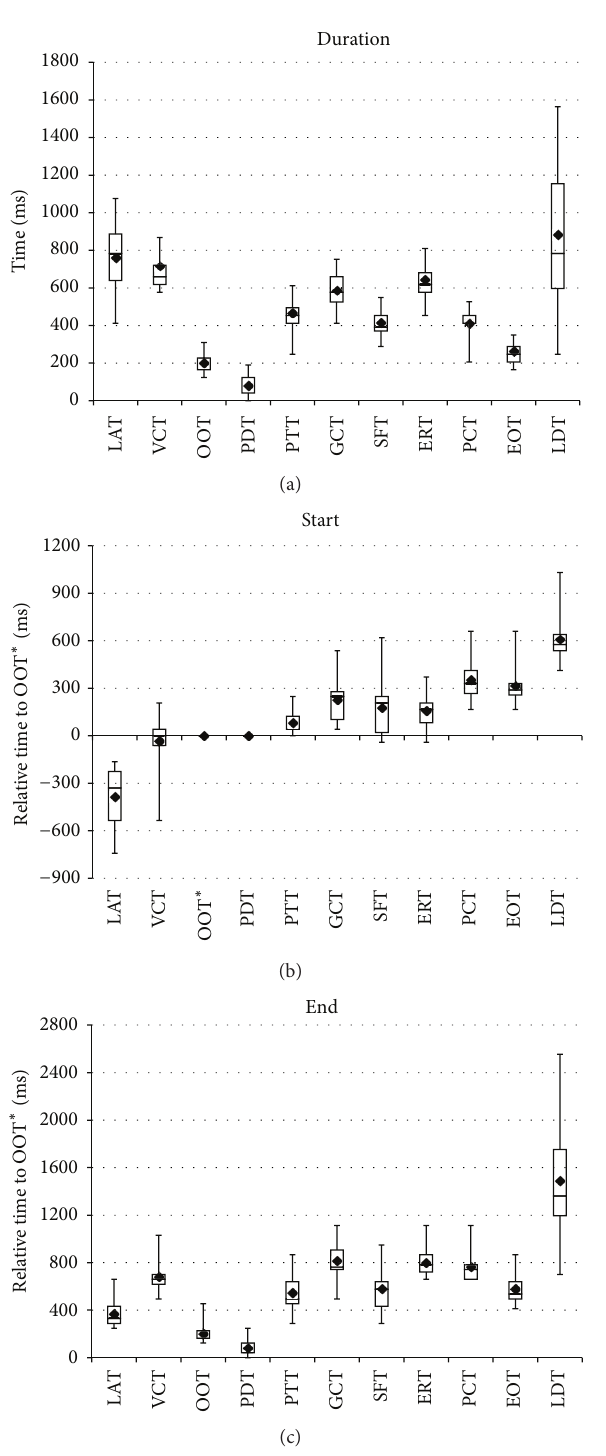
Figure 2: Durations, start times, and end times of distinct swallow- ing events as determined by real-time MRI (means and quartiles, 10 subjects). LAT: laryngeal ascent, VCT: velo-pharyngeal closure, OOT: oro-velar opening (start time defined as reference), OTT: oro-velar transit, PDT: pharyngeal delay, PTT: pharyngeal transit, GCT: glottal closure, SFT: vallecular and piriform sinus filling, ERT: epiglottic retroflexion, PCT: pharyngeal constriction, EOT: esophageal opening, and LDT: laryngeal descent.